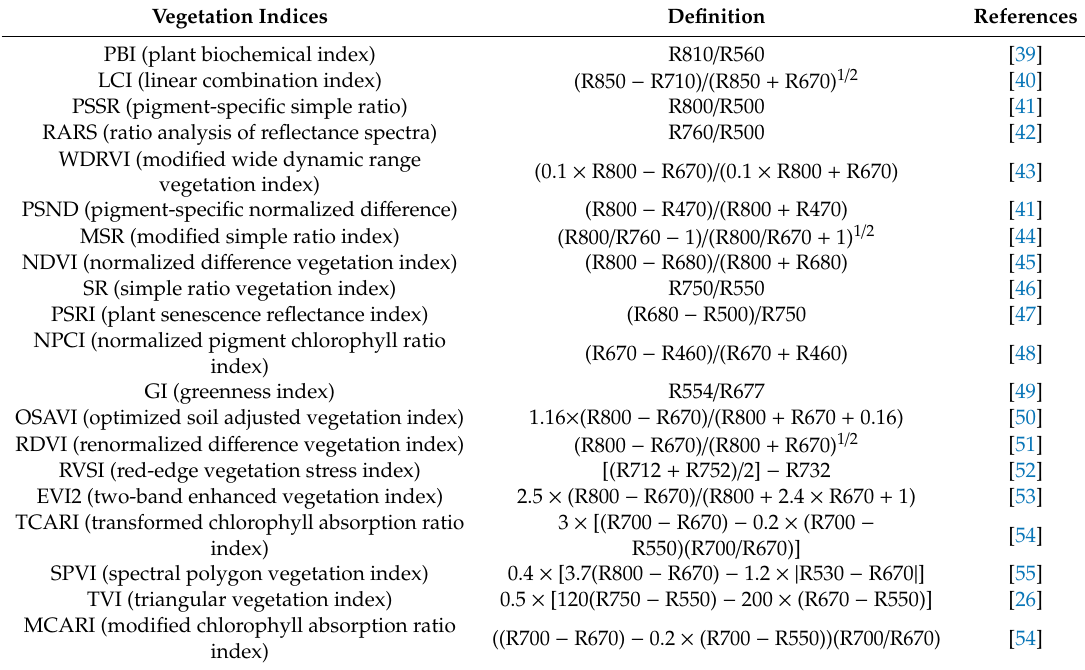
Table 2. Vegetation indices used in this